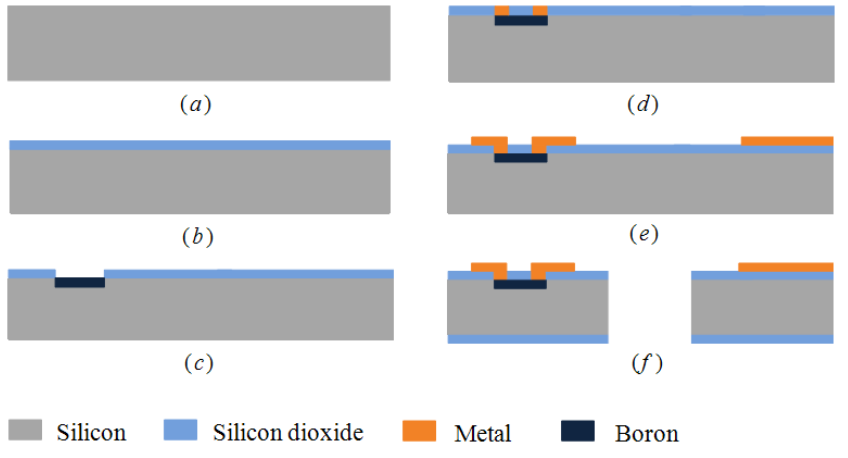
Figure 6. Micrographs of flexible beam and piezoresistors. (a) the flexible